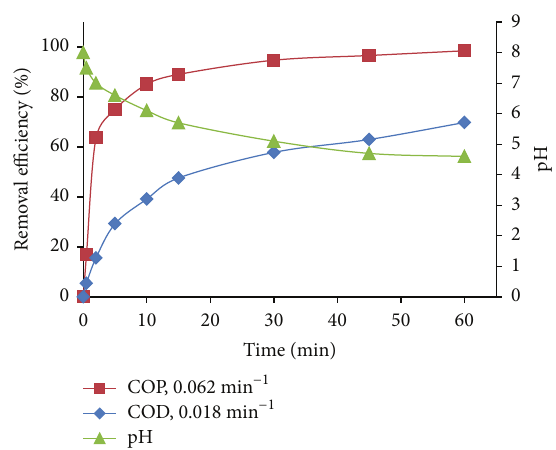
Figure 2: Effect of initial concentration of phenol on degradation efficiency in COP. Catalyst concentration of 2g/L; initial pH of 8 :0.